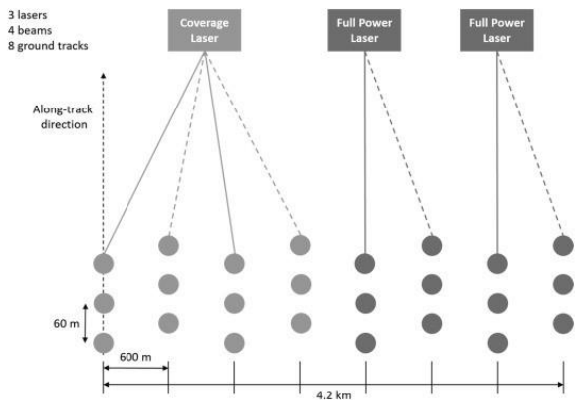
Figure 2. Ground sampling schema, from Dubayah et al. (2020)